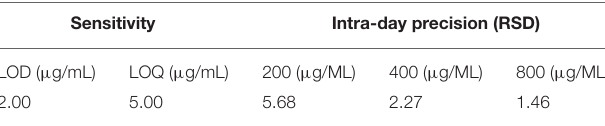
TABLE 2 | Sensitivity and intra-day precision of the analytical